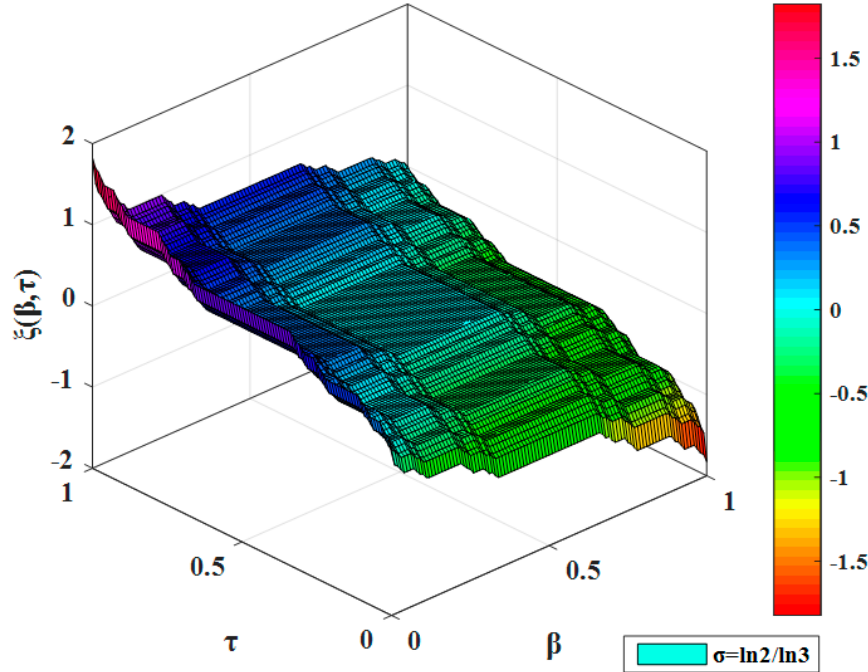
Figure 2. 3D plot of ξ ( β , τ ) w.r.t. β and τ in case of Example 2 for σ = ln2/